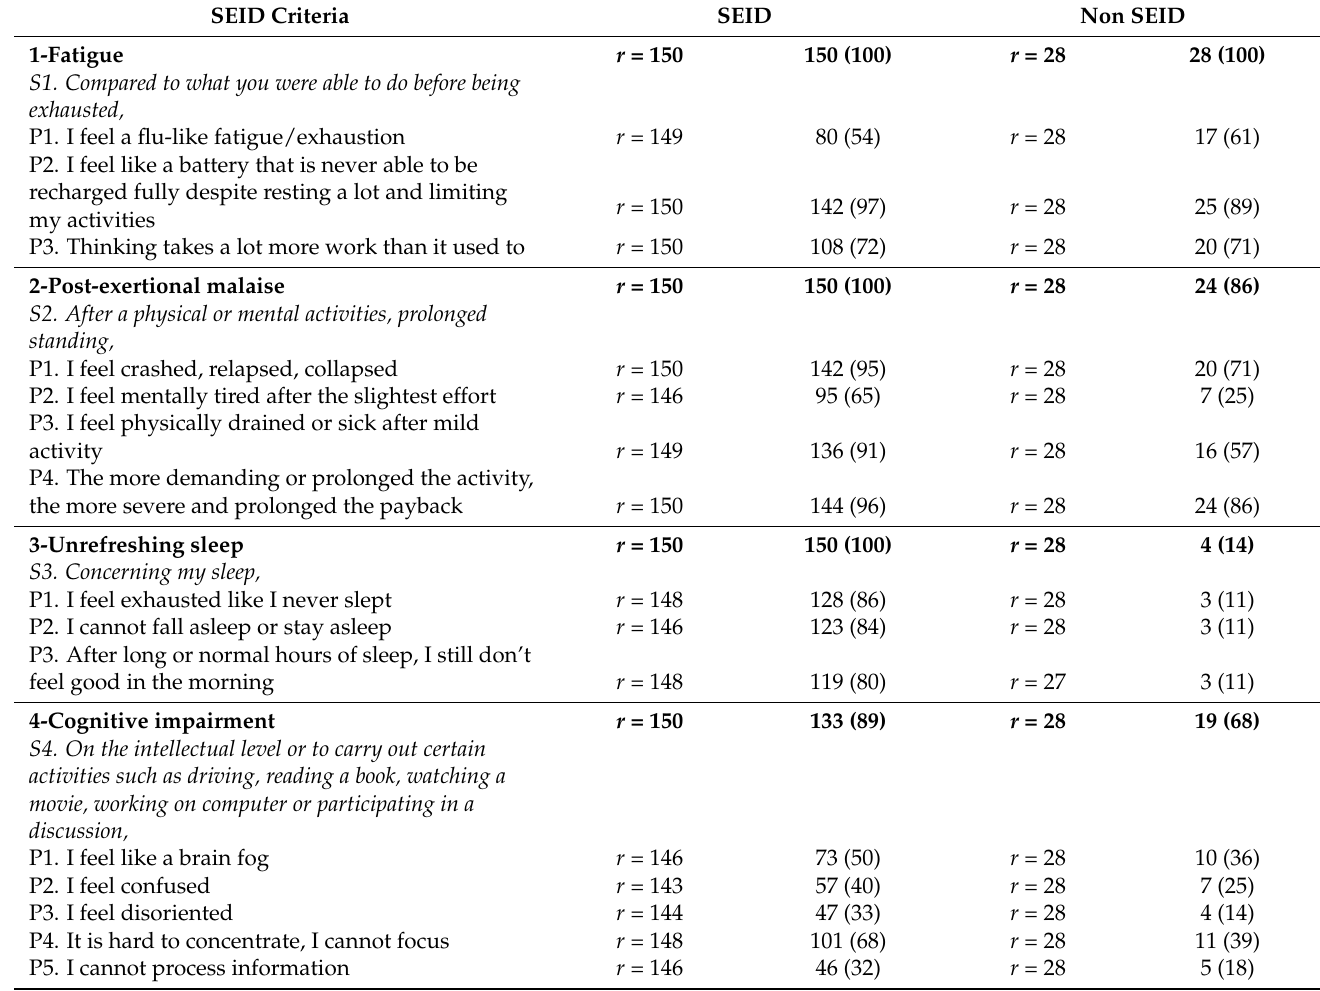
Table 2. Comparison of each question suggested by the IOM/NAM to assess SEID criteria between SEID and non-SEID patients. r , number of respondents to each item; (%); ns , not significant. SEID